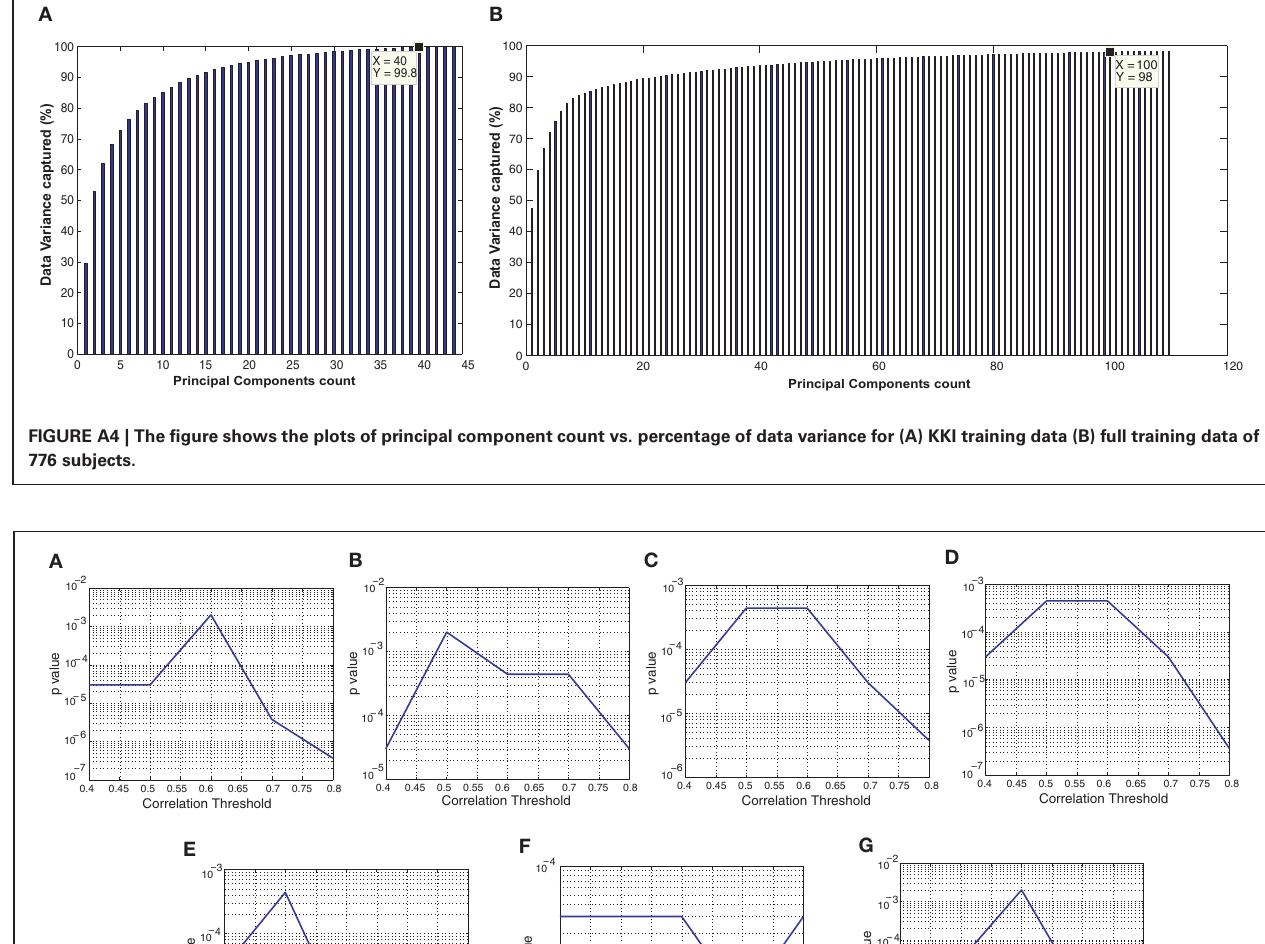
Correlation Threshold